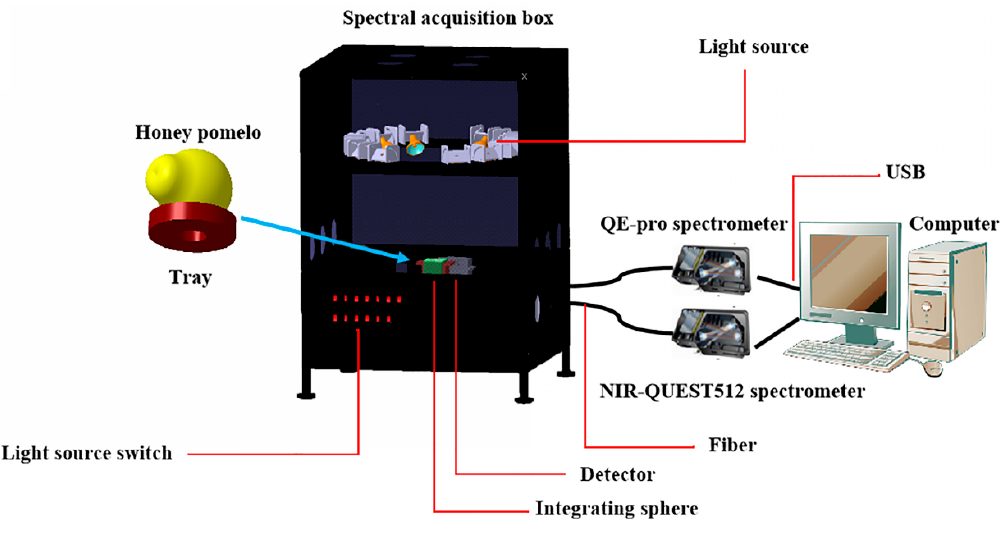
Figure 3. System used to acquire visible and near-infrared transmittance spectra.